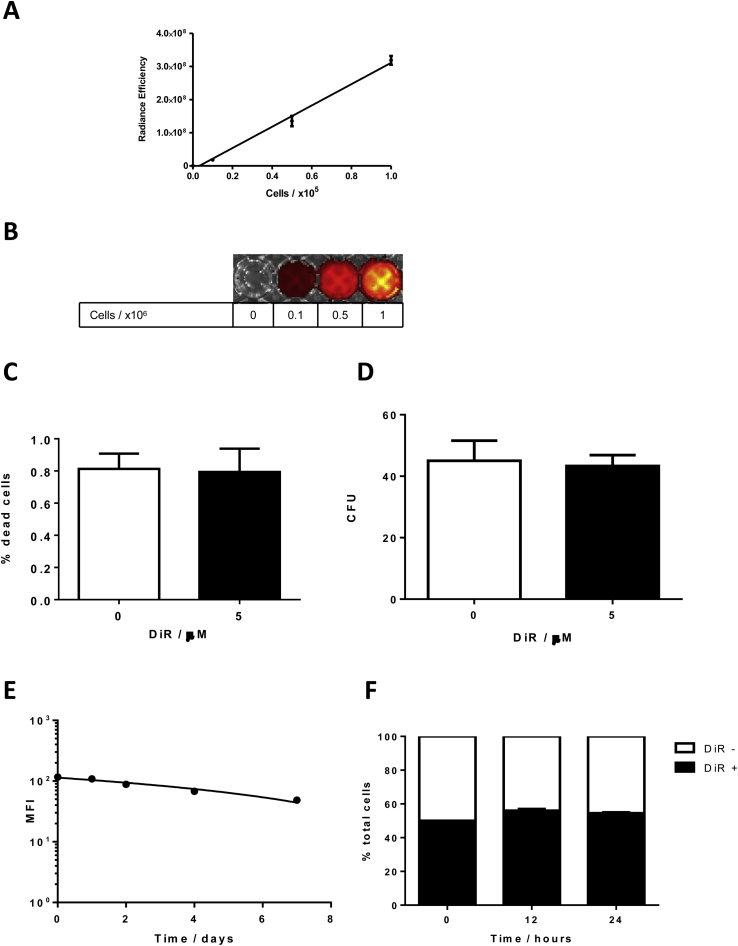
Validation of DiR staining. (A) Fluorescence intensity of varying numbers of cells labeled with 5 μmol/L DiR was measured using the IVIS imaging system (n = 3; means ± SD fluorescence shown). (B) Representative IVIS image (fluorescence intensity overlaid on photograph) of the indicated numbers of cells labeled with 5 μmol/L DiR for each. Freshly isolated KSL cells were incubated with 5 μmol/L DiR for 10 minutes at room temperature, washed, and resuspended in media. (C) Cell viability of labeled cells (black bars) was measured by viability dye exclusion determined by flow cytometry and compared with unlabeled cells (white bars) (n = 3; means ± SD % dead cells shown). (D) Colony-forming ability in labeled (black bars) and unlabeled (white bars) cells was measured by in vitro methylcellulose assay (n = 3; means ± number of colonies formed shown). (E) Loss of fluorescence over time: 1 × 106 cultured HPC-7 cells were labeled with 5 μmol/L DiR for 10 minutes at room temperature, washed, and resuspended in complete media. A cell sample was taken at each time point and mean fluorescence intensity (MFI) was determined by flow cytometry. (F) Potential transfer of dye from labeled to unlabeled cells: 1 × 106 cultured HPC-7 cells were labeled with 5 μmol/L DiR for 10 minutes at room temperature, washed, and resuspended in complete media together with 1 × 106 unlabeled HPC-7 cells. A cell sample was taken at each time point and the percentage of fluorescent DiR-labeled cells in the sample was determined by flow cytometry (n = 3; means ± SD % fluorescently labeled cells shown). CFU, colony-forming unit.